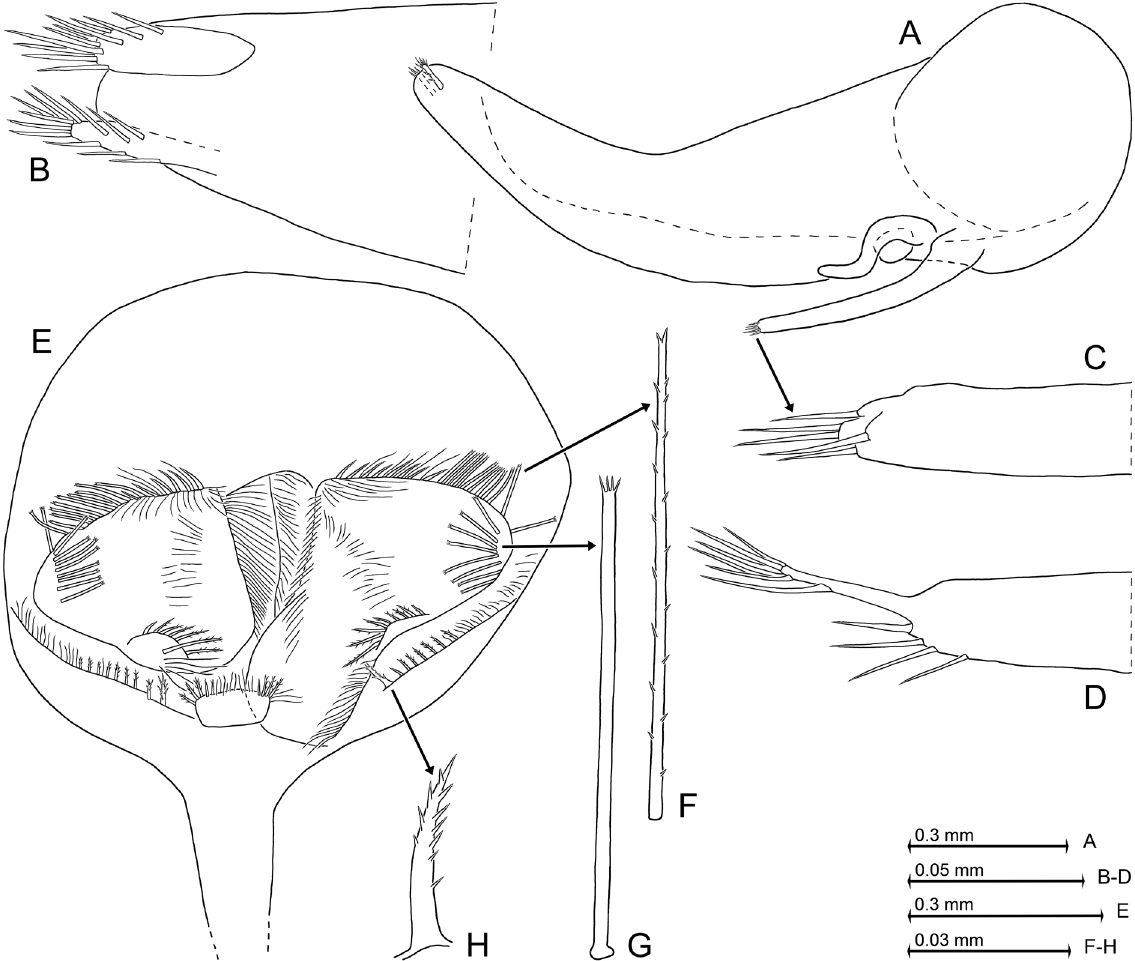
Fig. 8. Abyssomysis cornuta gen. et sp. nov., paratype female with body length 7.9 mm (E–H: ZMH 58256) and three of its nauplioid larvae at substage N2 (A–D). A . Nauplioid in toto, lateral. B . Tip of nauplioid abdomen in another specimen, obliquely dorsal. C . Detail of panel (A) showing tip of antennula. D . Tip of nauplioid antennula in another specimen. E . Cardiac portion of foregut, dorsal aspect, dorsal wall omitted. F–H . Details of E, showing modified